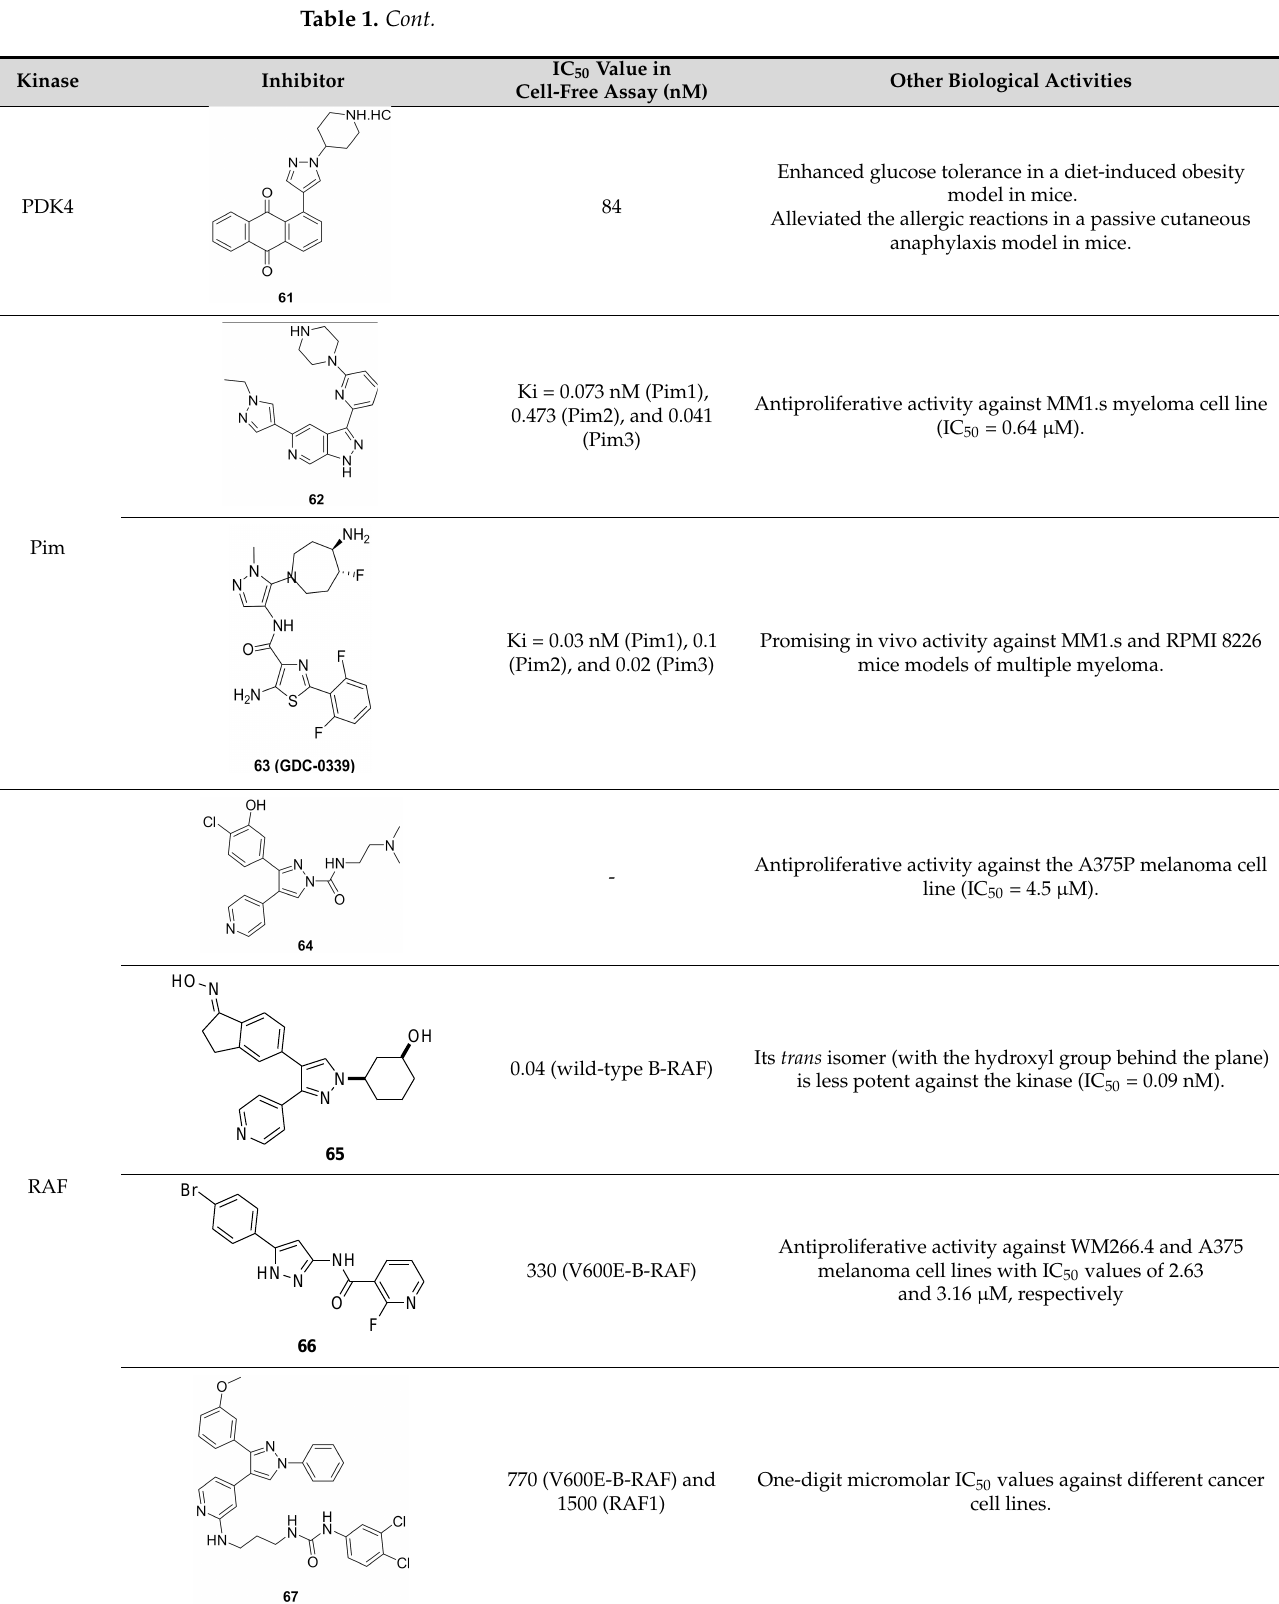
One-digit micromolar IC 50 values against different cancer cell